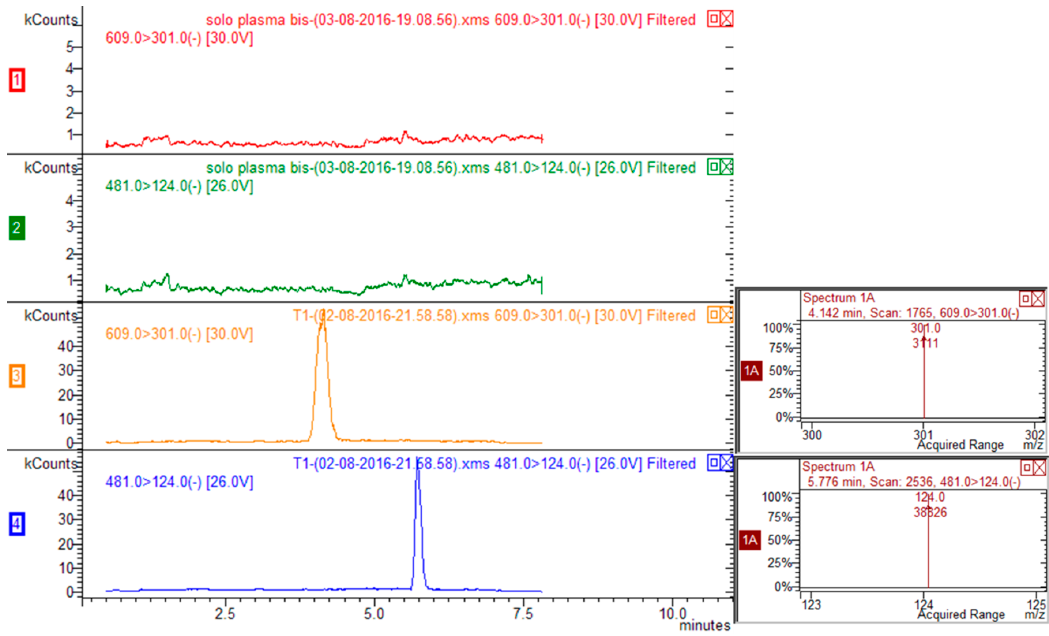
Figure 2. HPLC-MS/MS chromatograms corresponding to transitions 609 > 301 for rutin and 481 > 124 for ISTD (silimarin) of blank plasma (traces red and green for rutin and ISTD respectively) and plasma spiked with rutin and ISTD (traces yellow and blue for rutin and ISTD respectively).